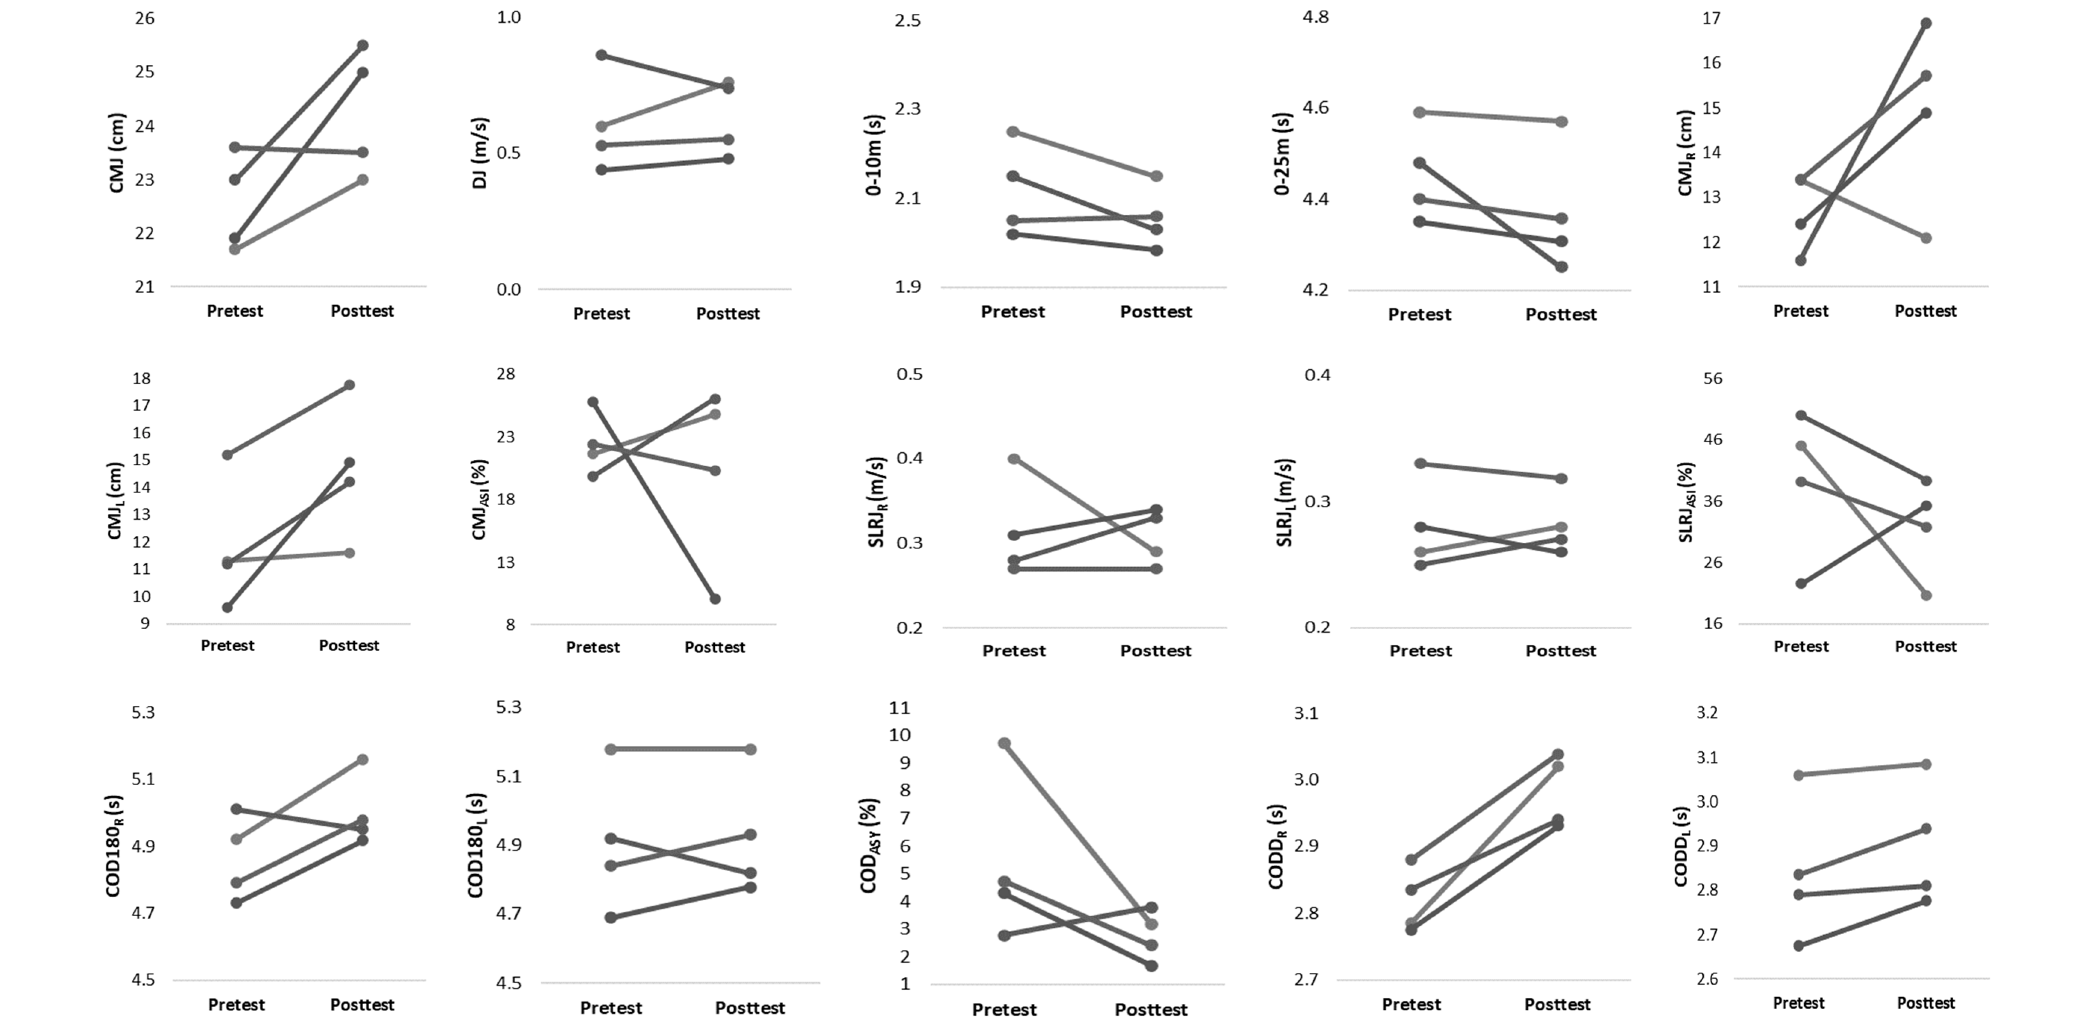
Figure 3. Individual changes from pretest to posttest for physical performance in COD group. Figure 4. Individual changes from pretest to posttest for physical performance in COD